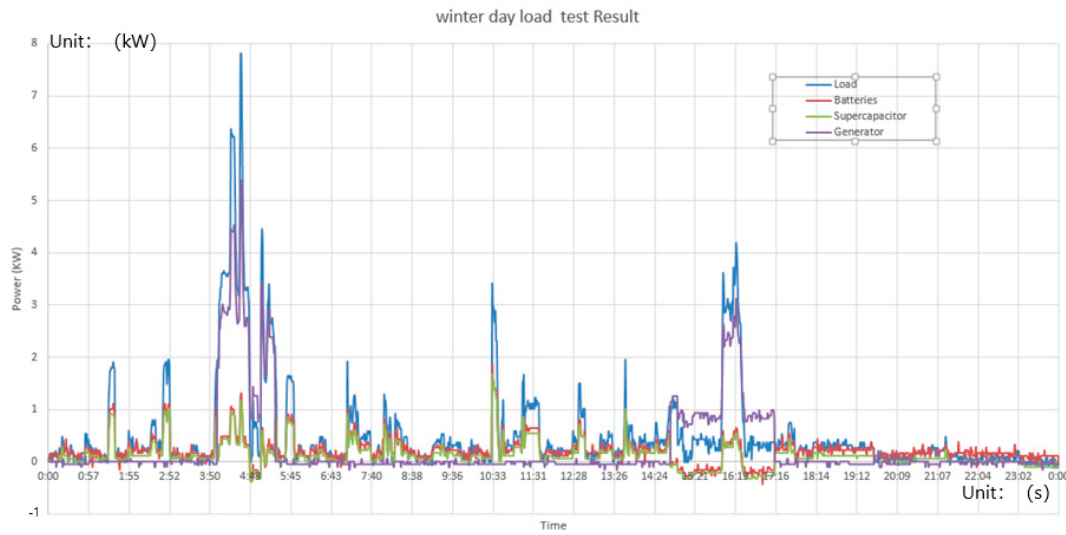
Figure 6. Winter day test results.